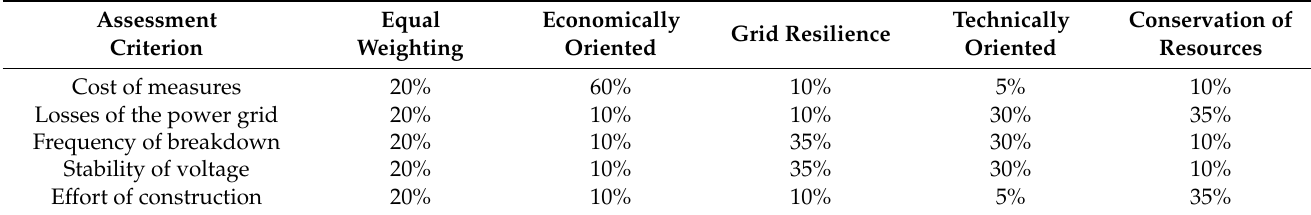
Table 6. An overview of the weighting alternatives and their specific weights based on